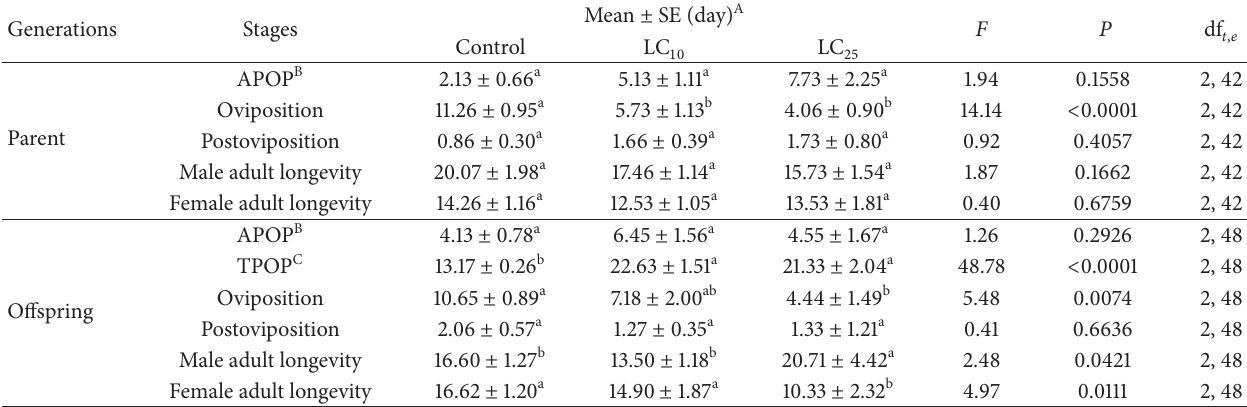
Table 4: The effects of sublethal concentrations of pyriproxyfen on preoviposition, ovipostion, and postoviposition periods and adult longevity of P. xylostella in parent and offspring generations.